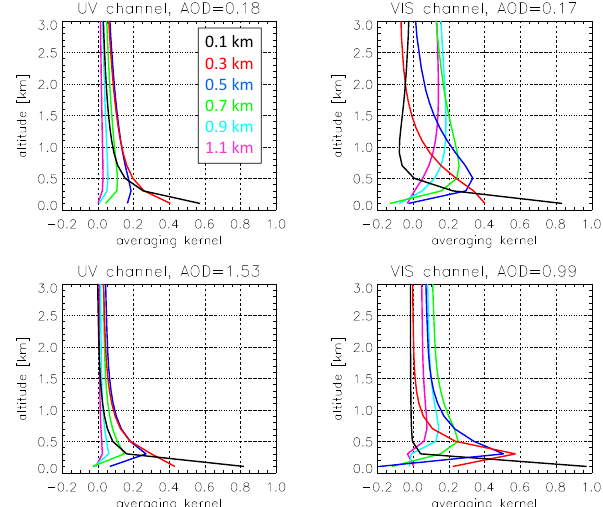
Figure 5. Examples of averaging kernels for retrievals performed with method A, both for the UV (left column) and Vis (right col- umn). The upper row shows averaging kernels for low AOD (rep- resentative for the winter season), the bottom row for high AOD (representative for the summer